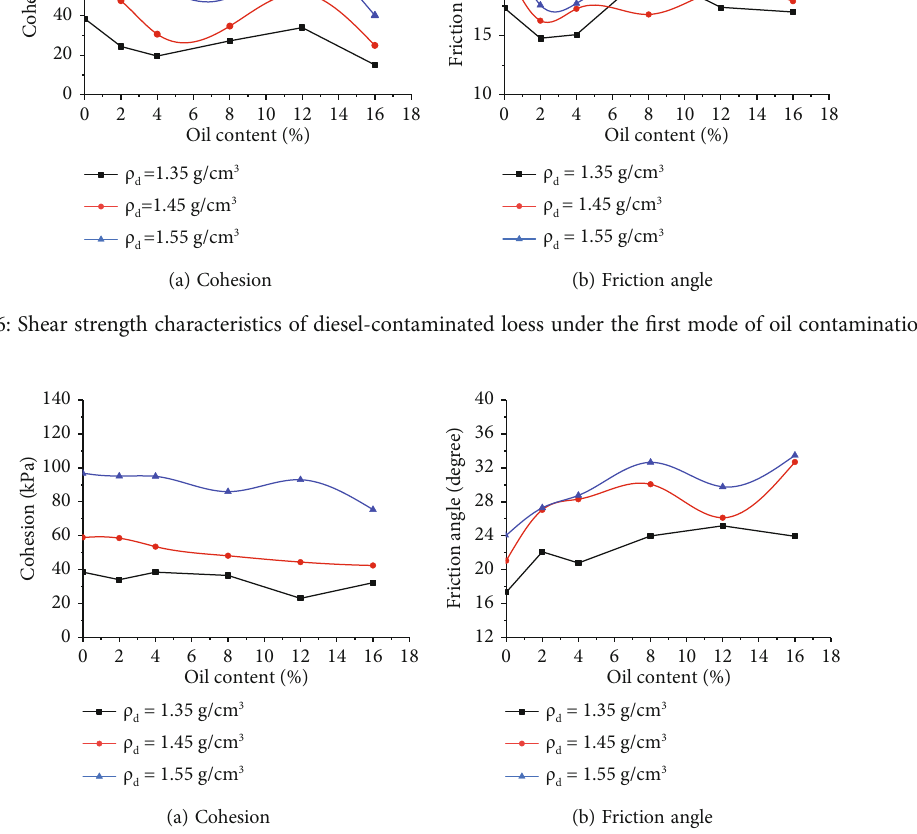
Figure 7: Shear strength characteristics of diesel-contaminated loess under the second mode of oil